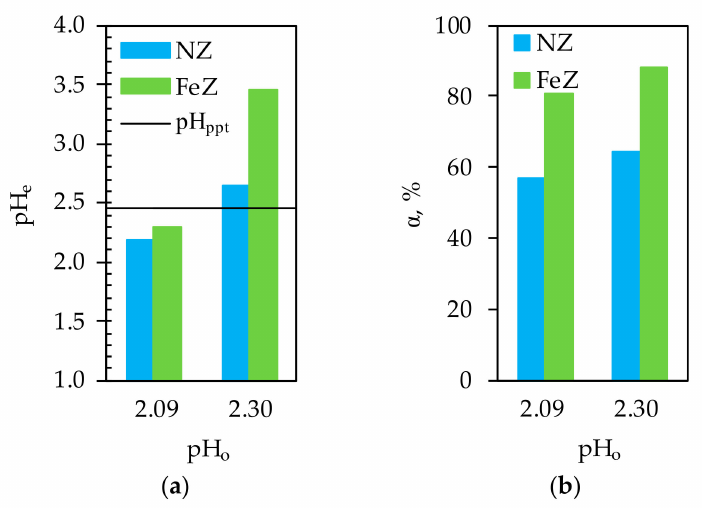
Figure 2. ( a ) pH e vs. pH o after sorption of Hg(II) onto NZ and FeZ. ( b ) The e ff ect of pH o on removal e ffi ciency, α of Hg(II) onto NZ and